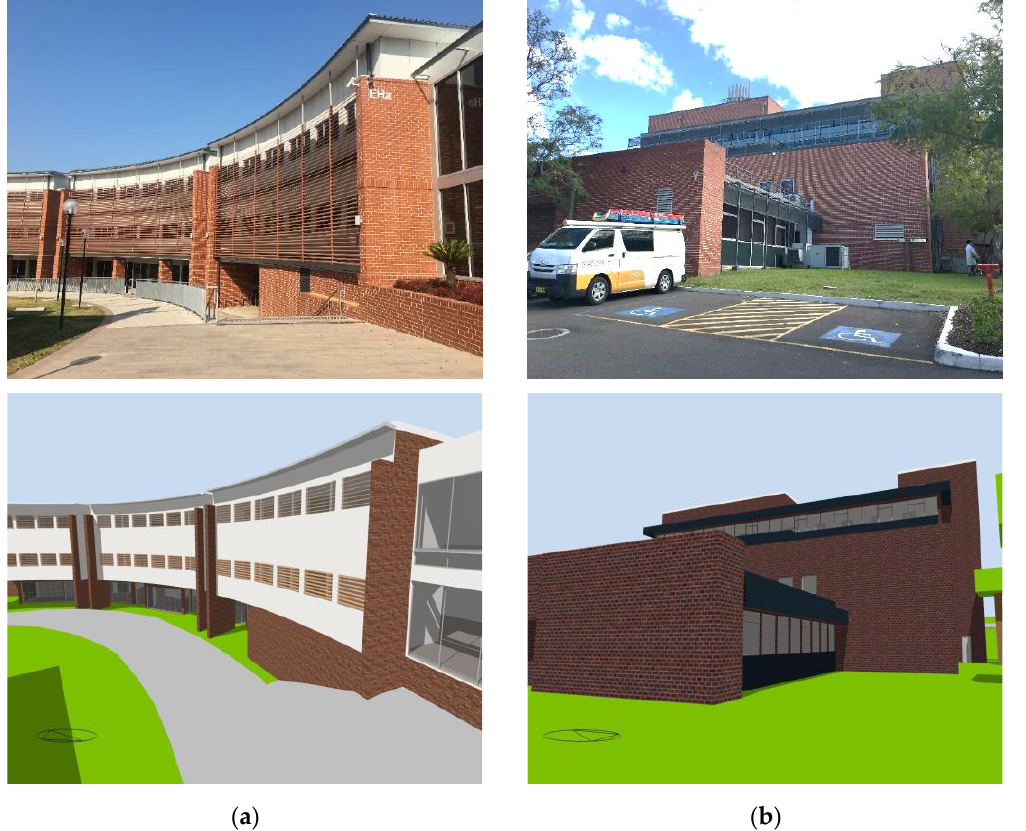
Figure 1. The real buildings and simulated models: ( a ) GB; ( b ) non-GB. Table 1. Characteristics of the proposed